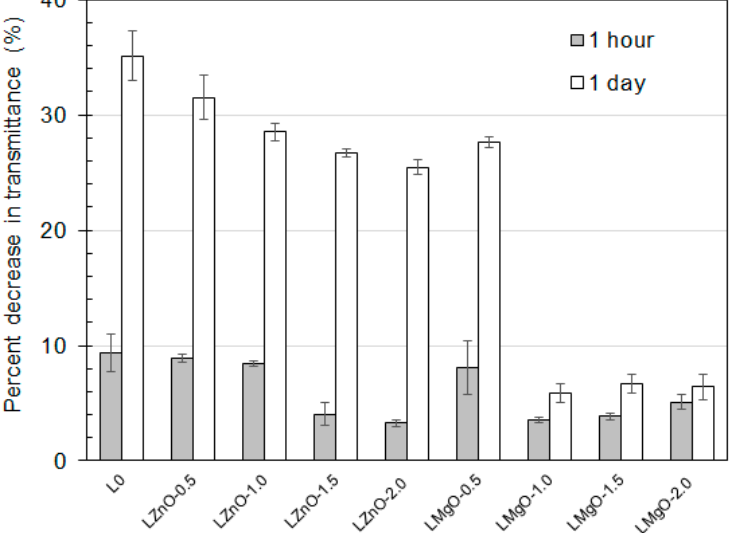
Figure 9. Water whitening (symbolized by transmittance decrease) of coatings applied on glass panels after their exposure in water for 1 h (grey columns) and 1 day (white columns).